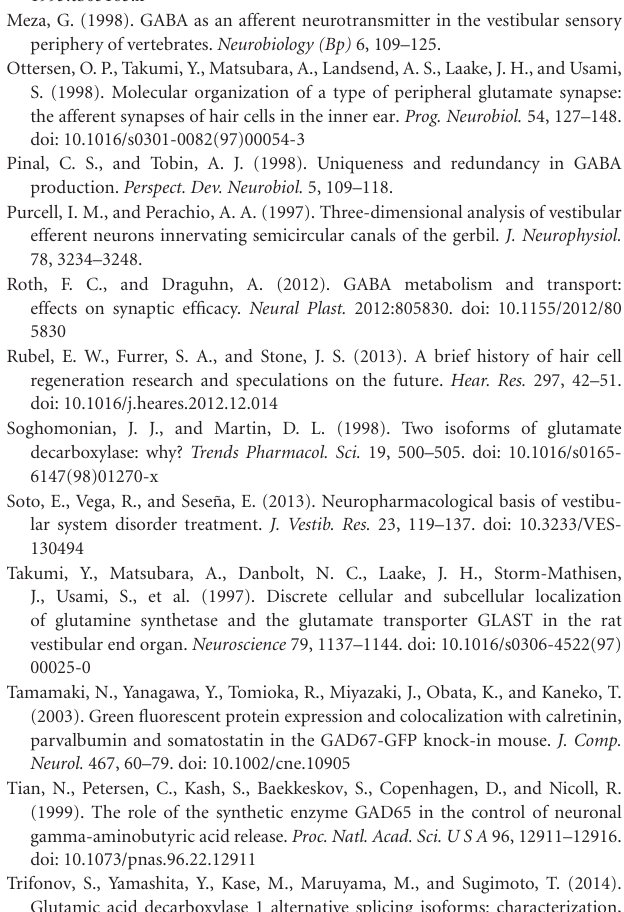
FIGURE 9 | Topographical distribution of GAD67 and GABA in the mouse vertical and horizontal cristae . Schematic representation showing the expression of GAD67 (green) by peripheral supporting cells as inferred by the confocal experiments. Red dots indicate supporting cell